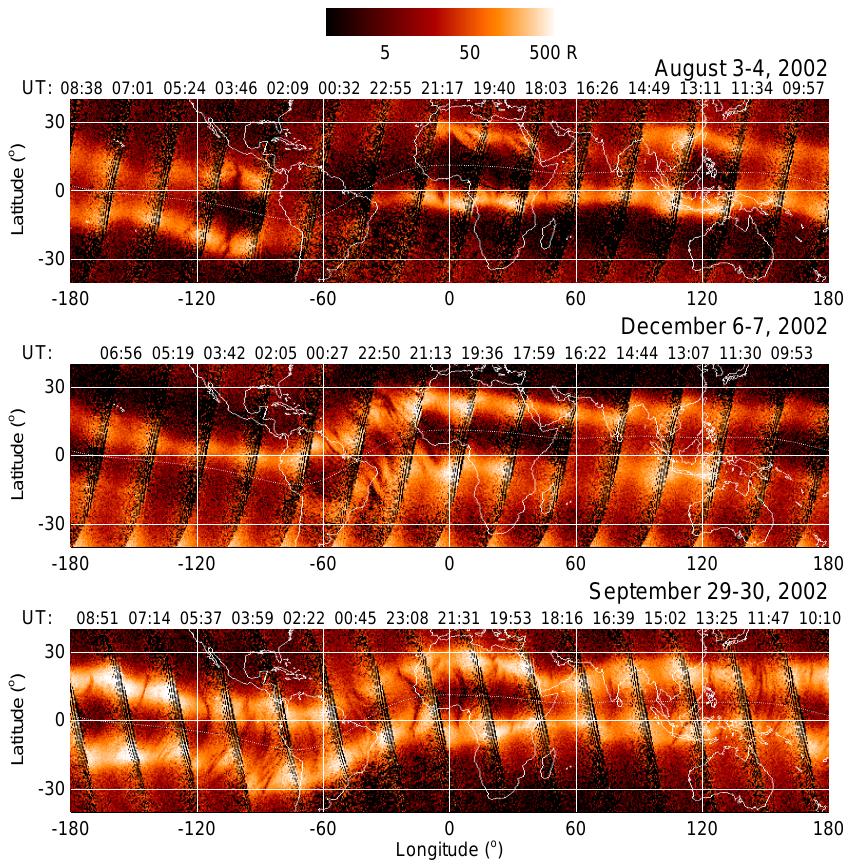
Fig. 1. Composite OI 135.6-nm radiance maps at 21:00 LT on 3–4 August (top), 6–7 December (middle), and 29–30 September (bottom) in 2002 . The bright arcs are produced by the EIAs. The dark bands within each swath of GUVI data result from plasma